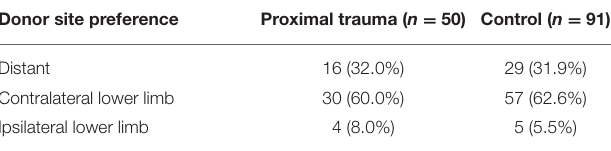
TABLE 5 | Free flap donor site preference.